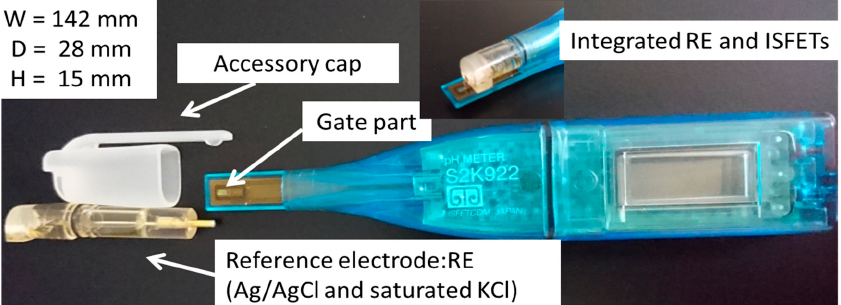
Figure 1. pH-sensitive ion-selective field-effect transistors (pH-ISFETs) and accessory cap.